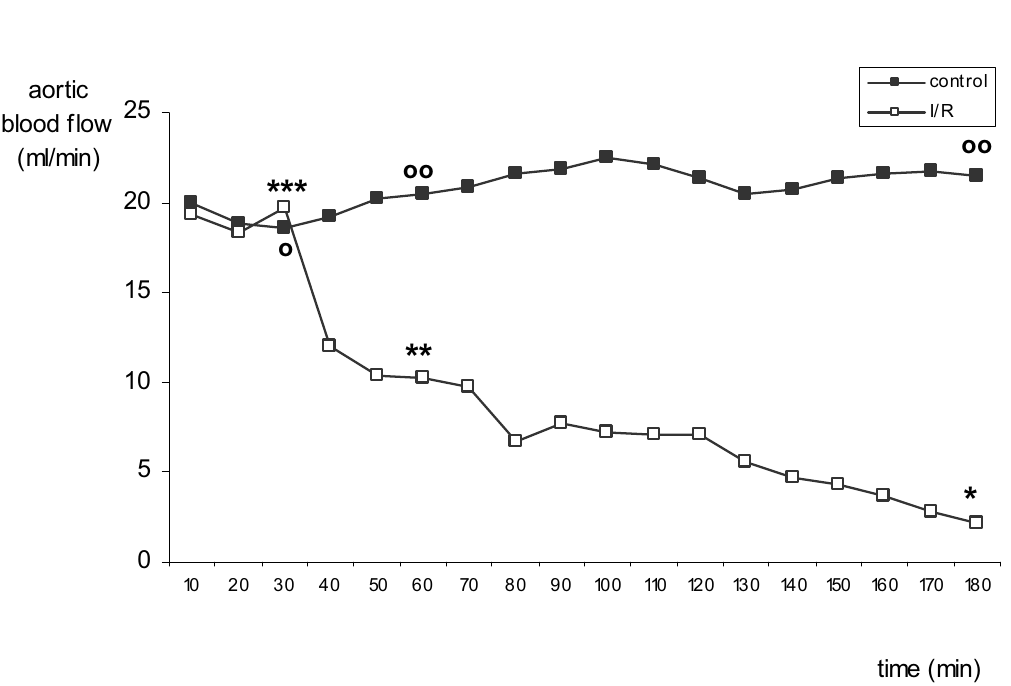
FIGURE 3 – Median aortic blood flow (ml/min) along time. Asterisk and circle indicate significant differences according experimental time in I/R and control groups, respectively (p < 0.05)